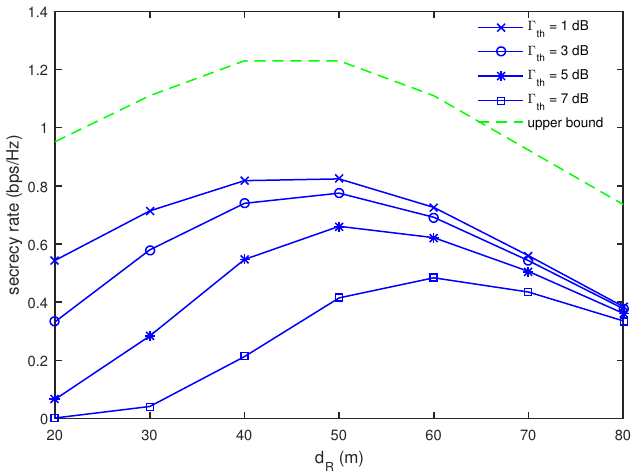
Figure 5. Comparison of multicast secrecy rate as a function of d R for different values of Γ th when M = 4 and I = J = K = 2.